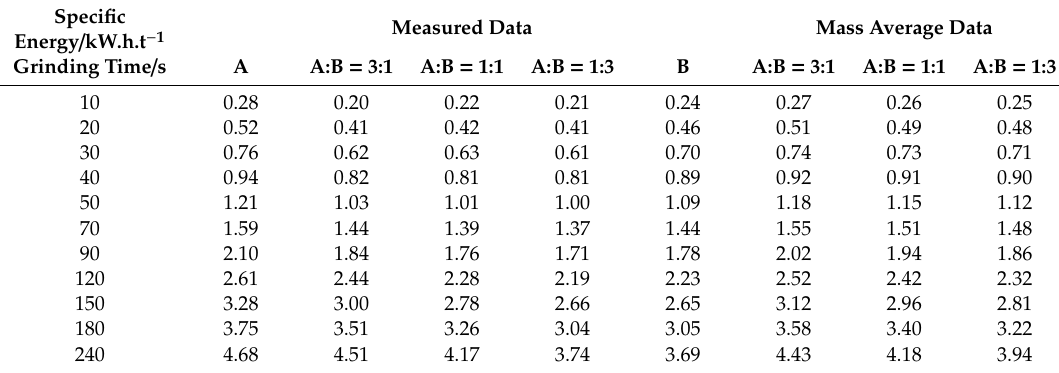
Table 3. Comparison of measured and mass average specific